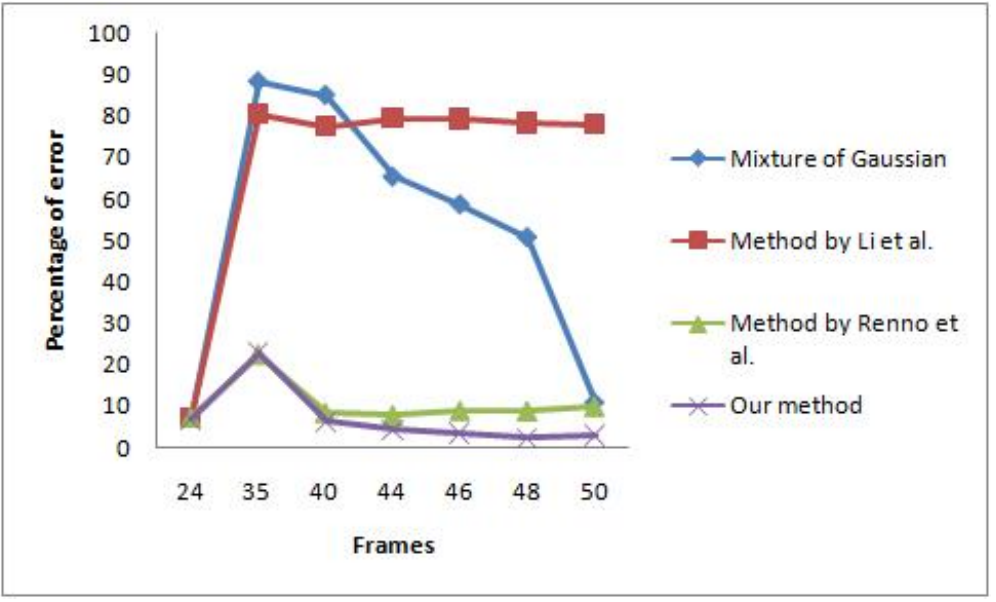
Figure 8. Rate of response of the algorithms under sudden illumination